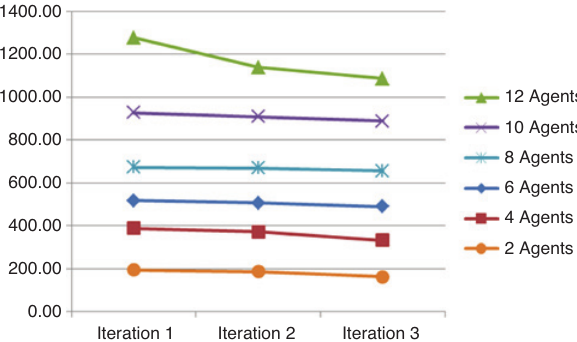
Figure 6: Processing Time Regression.